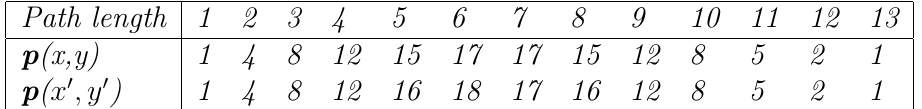
( 𝑥, 𝑦 ) = 15 while 𝑝 ( 𝑥 ′ , 𝑦 ′ ) = 16 5 5